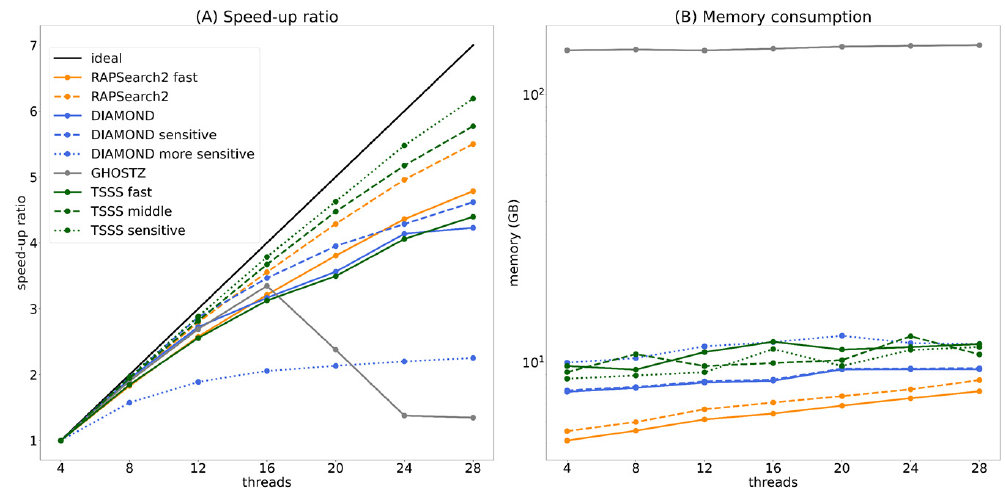
Figure 8. Speed-up ratio ( A ) and memory consumption ( B ) for parallel